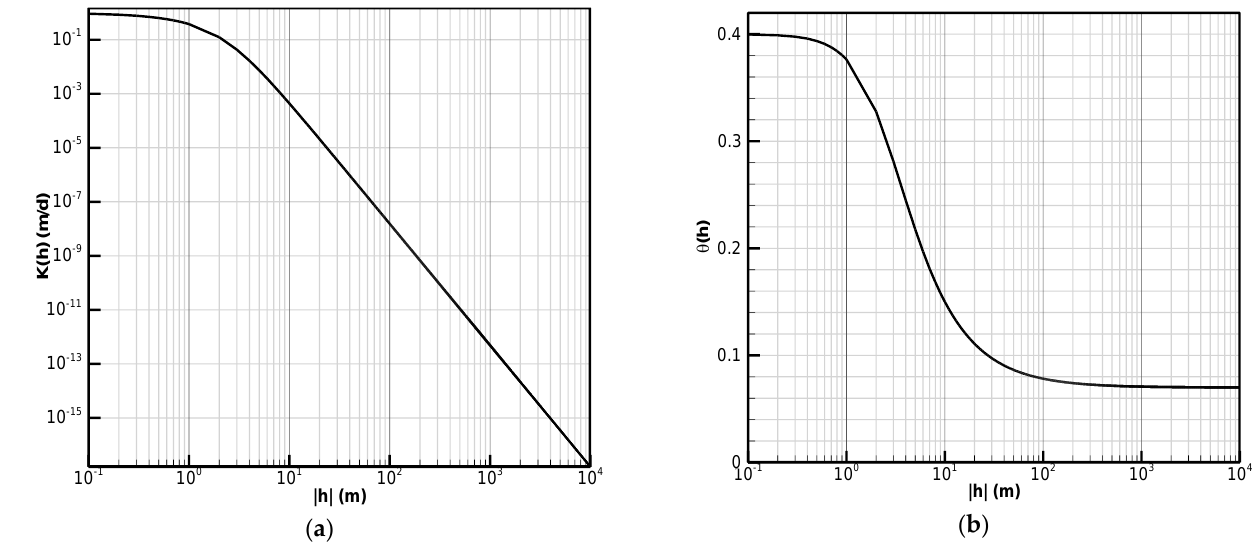
Figure 1. Moisture retention and hydraulic conductivity curves: ( a ) is the hydraulic conductivity curve and ( b ) is the moisture retention curve.